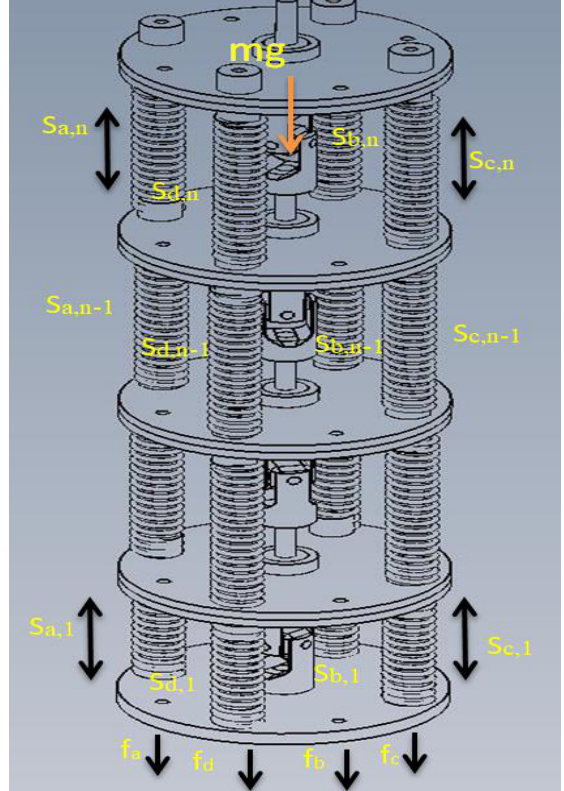
Figure 19. End-section kinetic structure.